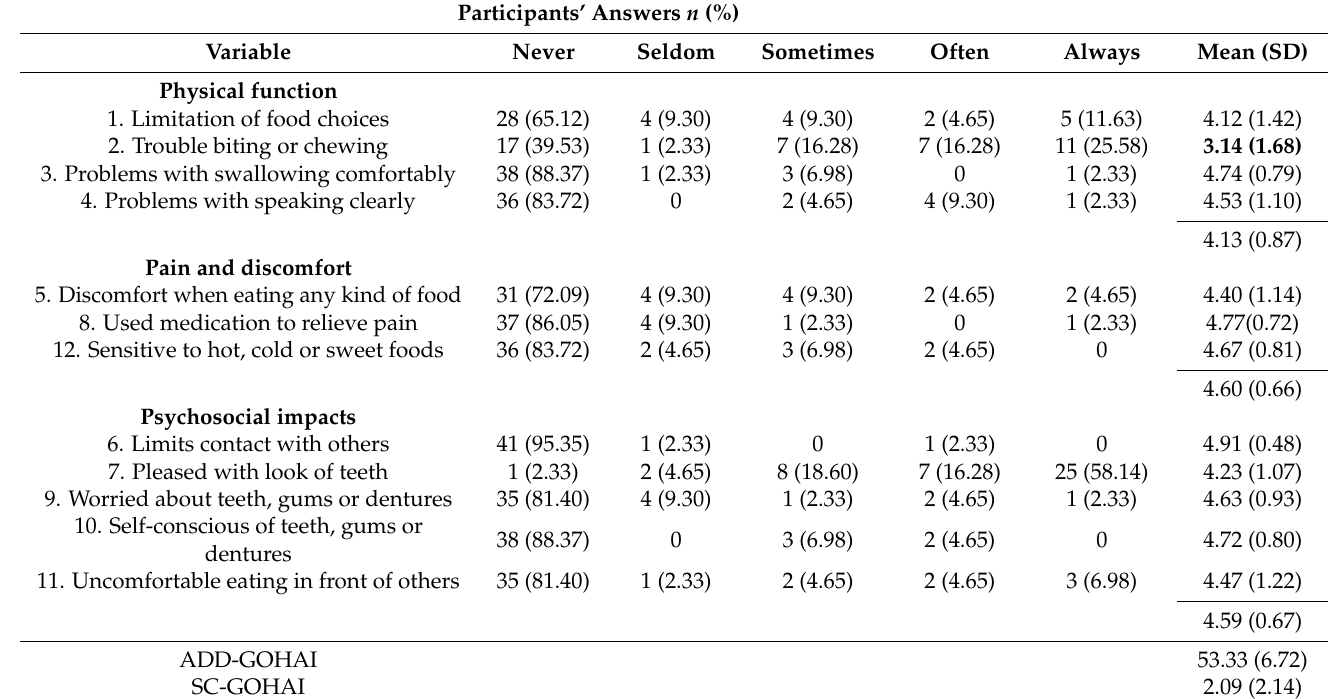
Table 3. OHRQoL in centenarians: Geriatric Oral Health Assessment Index ( n = 43).